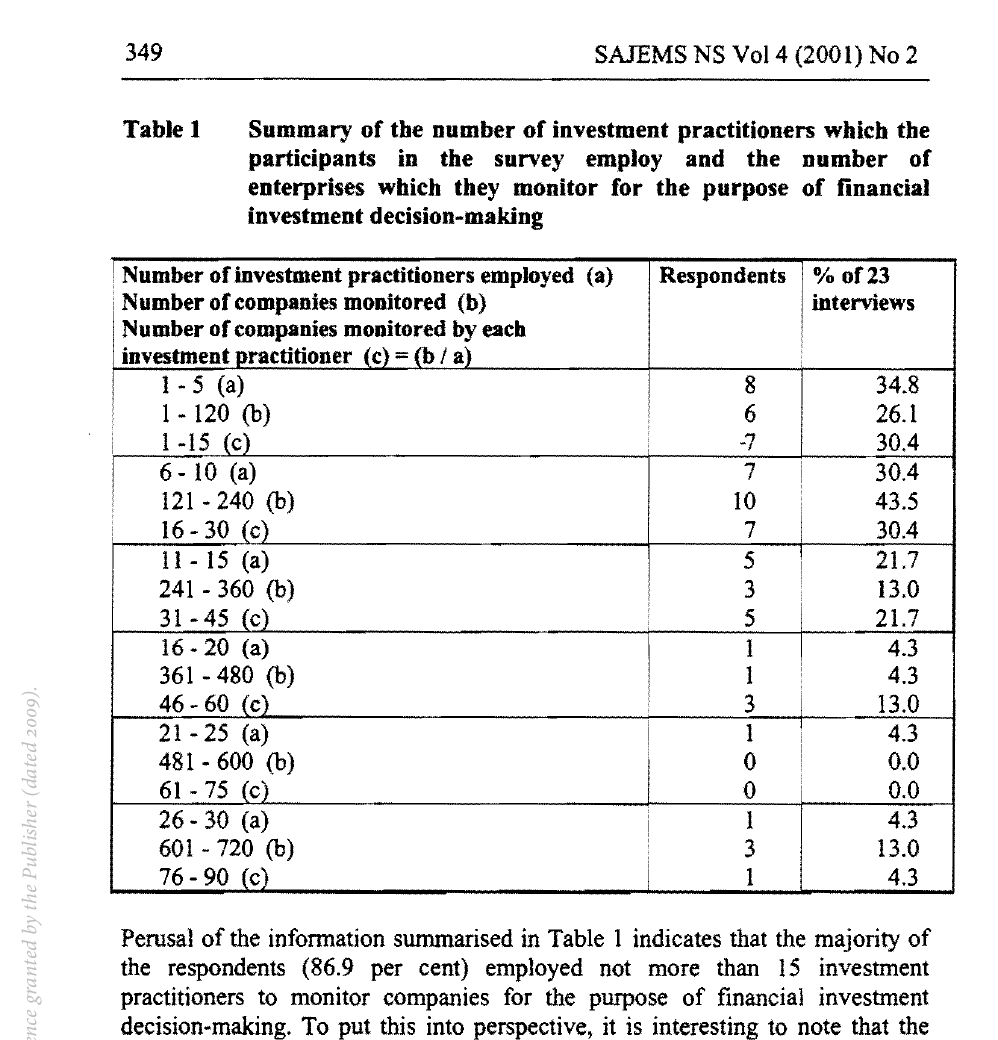
Table 1 Summary of the number of investment practitioners which the participants in the survey employ and the number of enterprises wbich they monitor for tbe purpose of financial investment